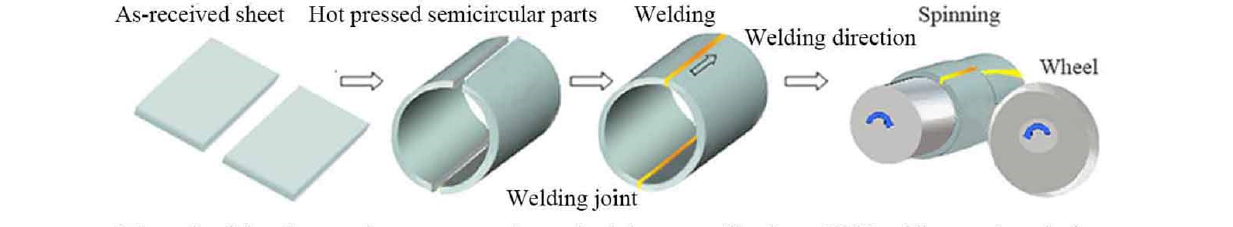
Figure 1. Schematic of hot power spinning assisted by on-line electro-magnetic induction heating.